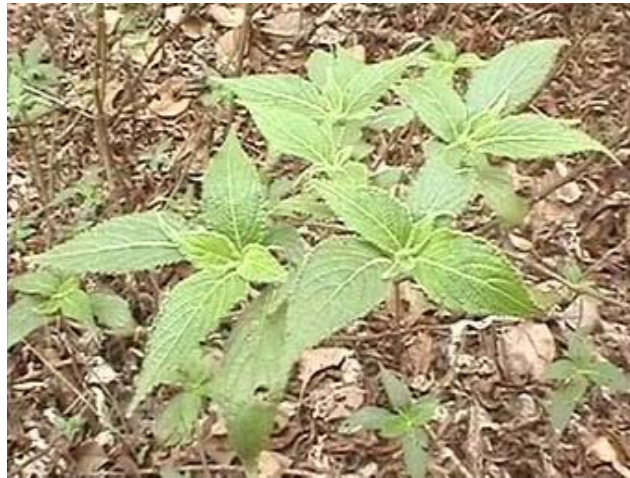
Image 2. Strobilanthes ixiocephalus - the most preferred food plant of Gaur ( Bos gaurus